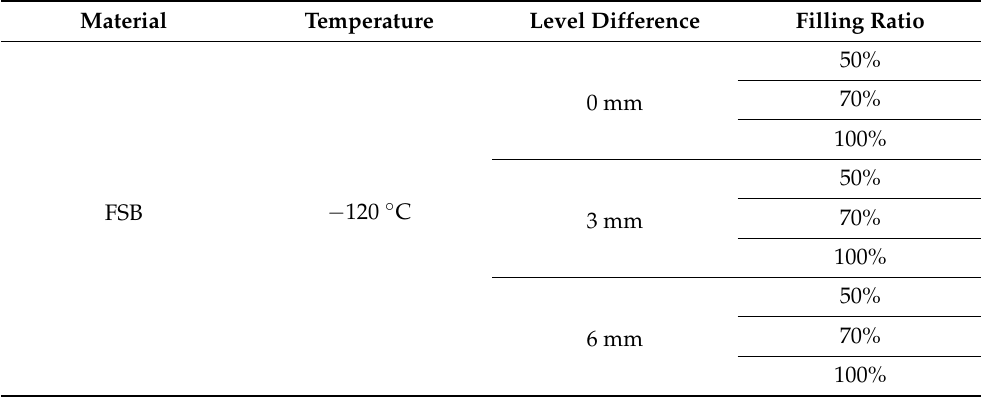
Table 1. Mechanical test scenarios for the